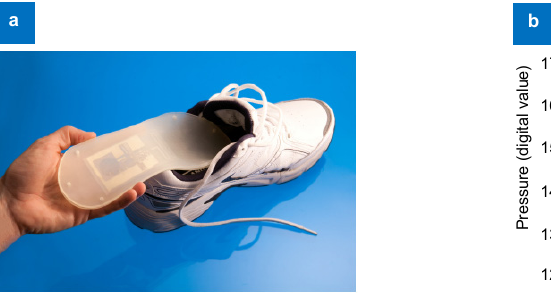
Fig. 3 | Fabrication procedure of fully encapsulated capacitive sensor with 3D printing . ( a ) Polycarbonate (PC) substrate with recesses designed for all electronic components. ( b ) Components arranged in in the PC substrate. ( c ) Electrical components with corresponding embedded wiring. ( d ) Completed capacitive sensor with fully embedded wiring, diodes, LEDs, resistors, and a microcontroller 21 .